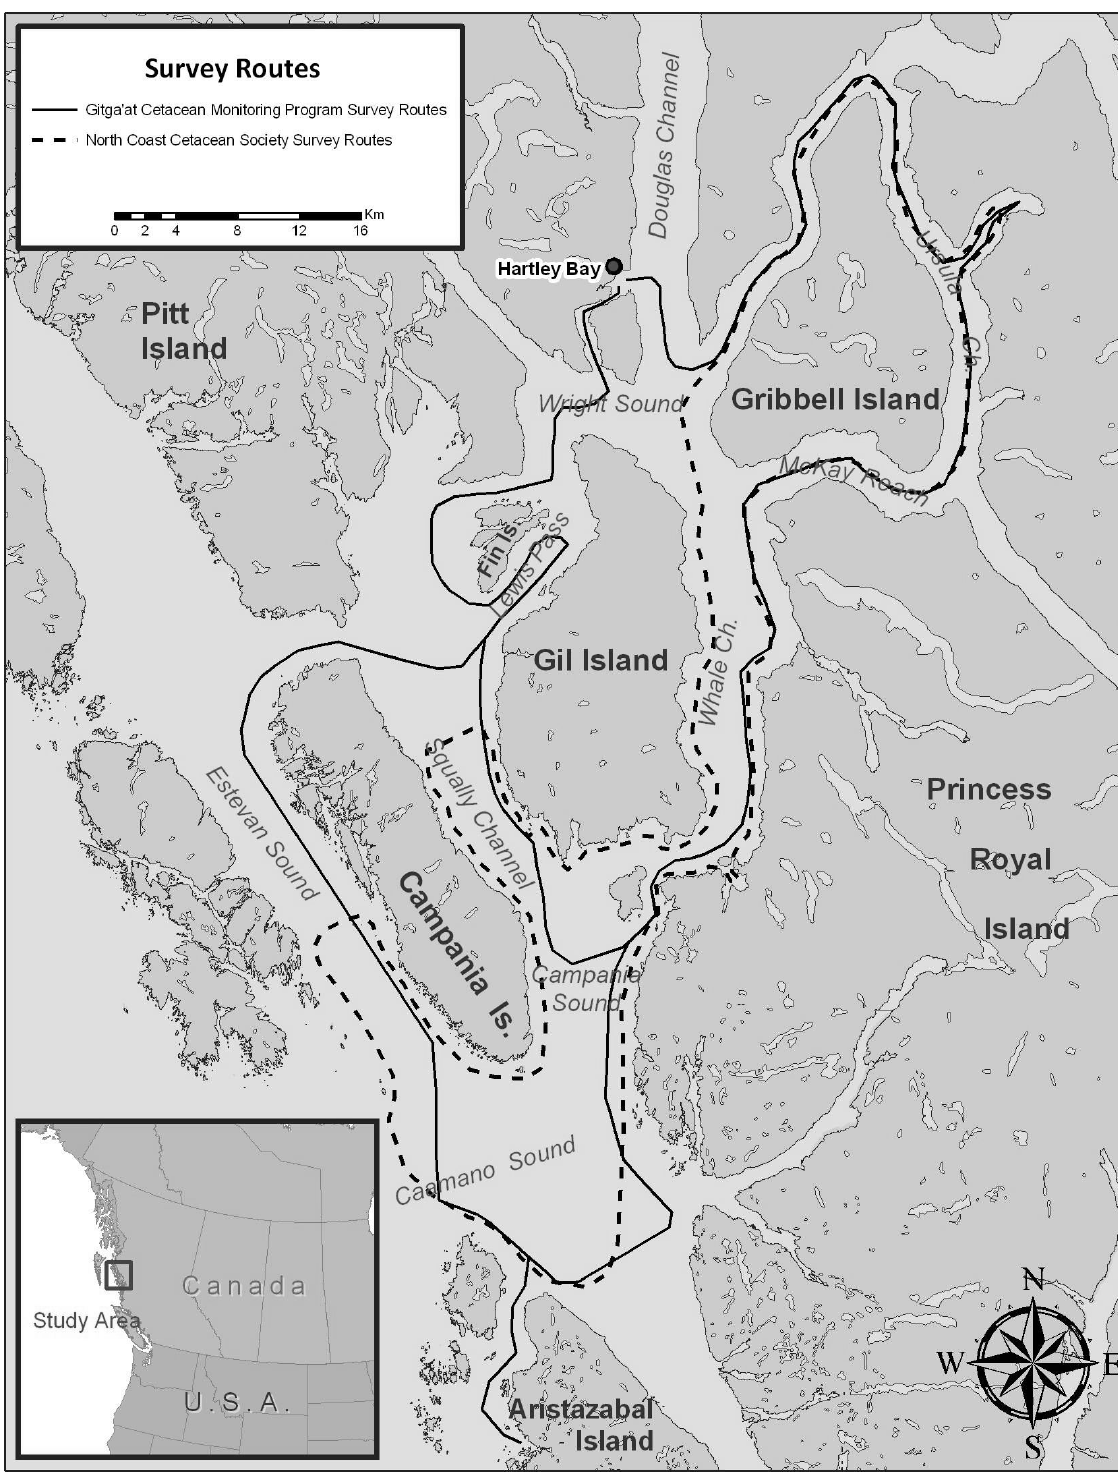
Figure 1. Map of study area and a typical survey route followed by Gitga’at (solid line) and Cetacealab (dashed line). The outer route (solid line, westernmost boundary) shows the route followed when weather conditions allowed observers to search for whales in exposed waters, while the inner line shows the route that would be explored when weather conditions were limiting.